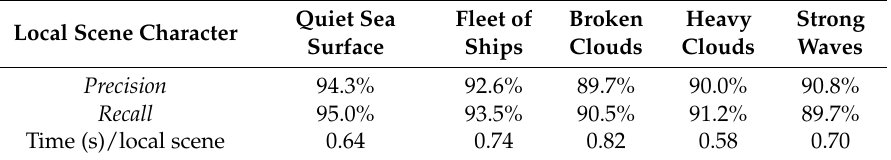
Table 4. SFCM ship candidate extraction performance.